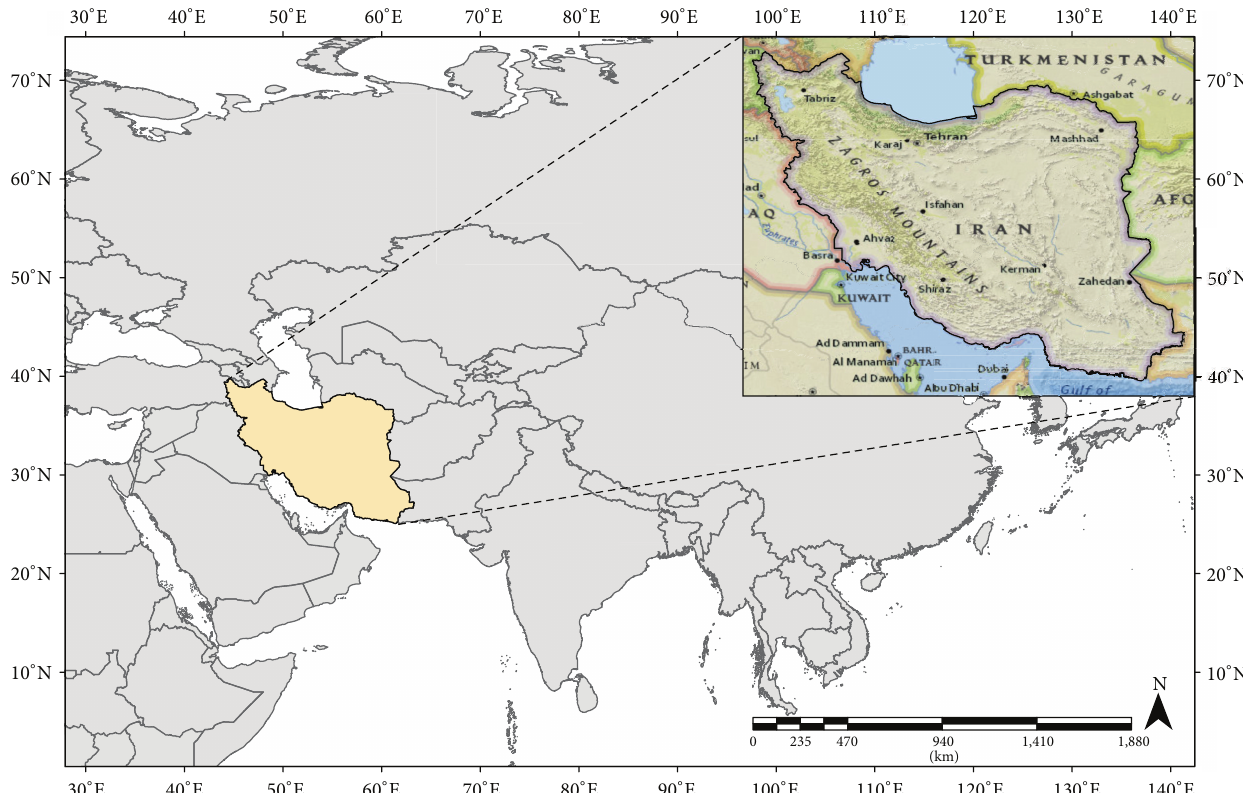
Figure 1: Location of Iran with stylized topographic depiction. Elevation ranges from − 28m near the Caspian Sea to 5610 m atop Mt.